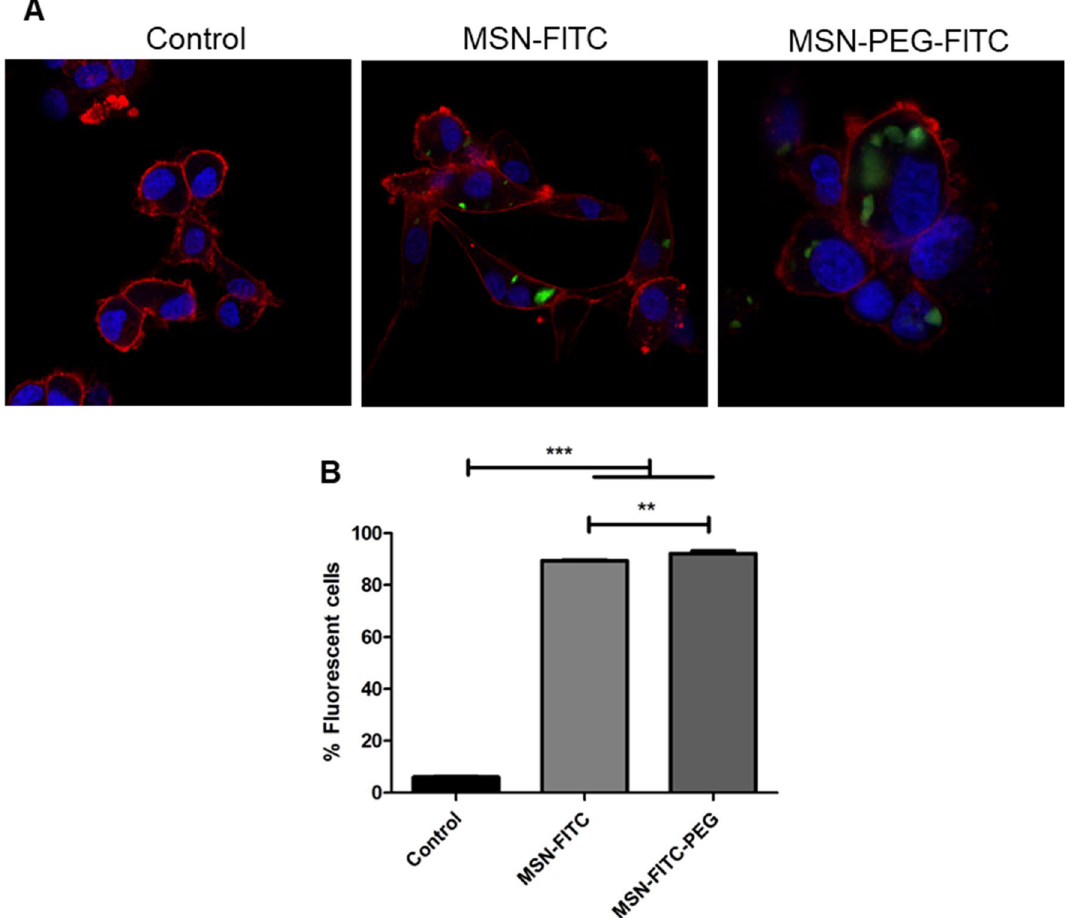
Figure 5. The MSN are internalized on U-87 glioblastoma cells. ( A ) Confocal Fluorescence microscopy of U-87 cells after 24 h treatment with 50 µg/ml MSN-FITC and MSN-FITC-PEG. ( B ) Fluorescent cells detected by flow cytometry after 24 h treatment with 50 µg/ml MSN-FITC and MSN-FITC-PEG. Control = cells without the addition of nanoparticles. Statistical test: One-way ANOVA with Tukey’s post-test comparing all treatments. P < 0.05 (*), P < 0.01 (**) or P < 0.001